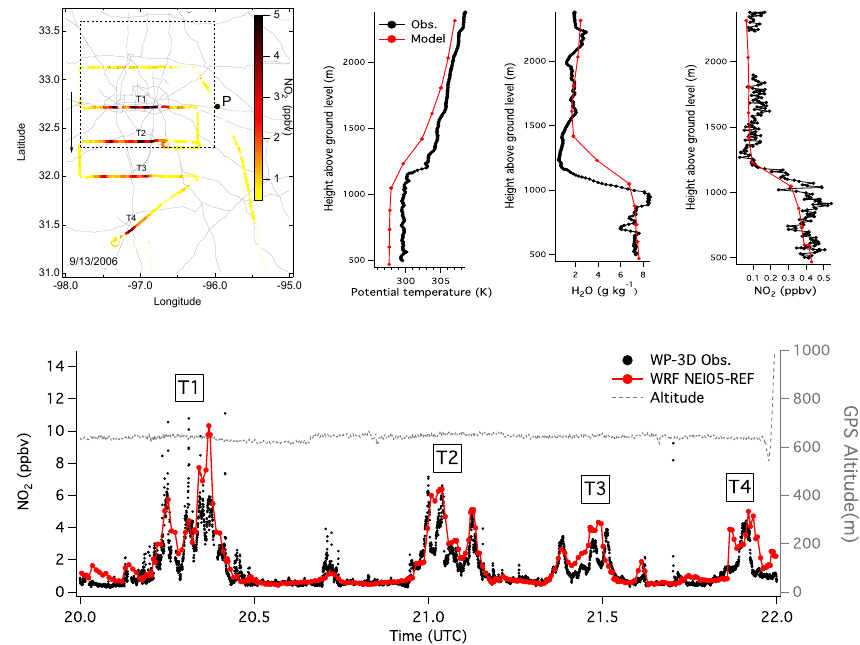
Figure 7. Map (top left) of the flight tracks on 13 September 2006 capturing Dallas-Fort Worth urban plumes. The WP-3D NO 2 mixing ratio is color-coded over the flight tracks. Arrow denotes a flight track in north-south direction. A box with dashed line on the map is Dallas-Fort Worth region used for the satellite-model comparison (Fig. 1 and Table 4). T1–T4 represent transect 1–4. Vertical profiles of potential temperature, water vapor mixing ratio, and NO 2 measured by the WP-3D at a point “P” on the map are shown (top right). The WRF-Chem model and WP-3D NO 2 for the segments of the flight are compared (bottom).